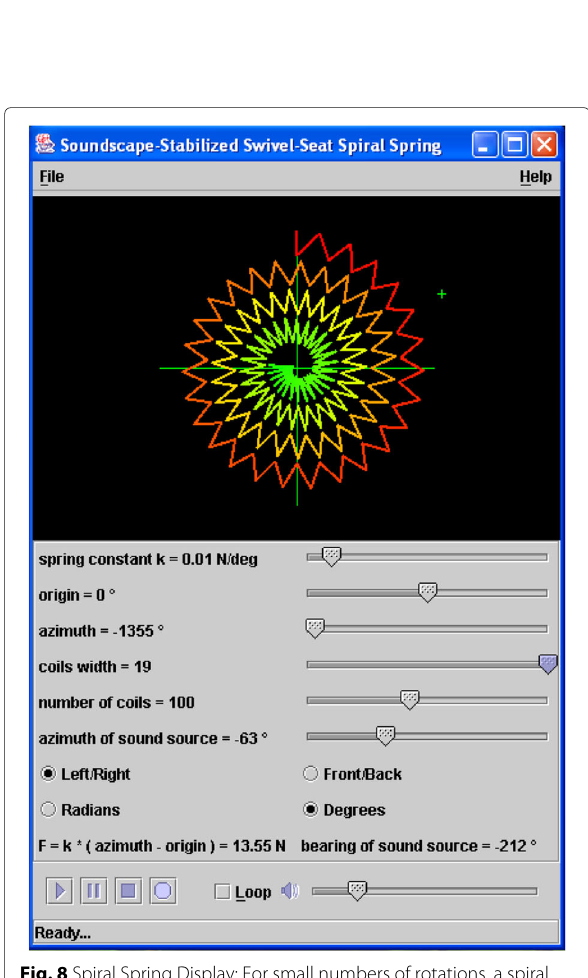
Fig. 9 The University of Aizu 3D Theater display systems, featuring ceiling-mounted speakers for sound diffusion and multiple